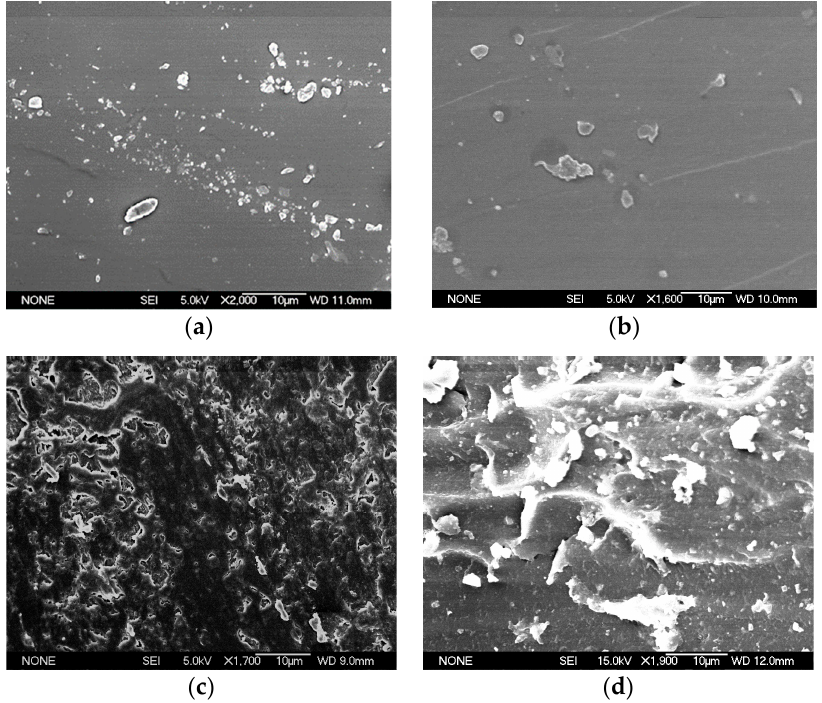
Figure 2. SEM images of various semi-IPNs: ( a ) 2 NRM 20 ; ( b ) 2 NRM 35 ; ( c ) 2 NRM 55 ; ( d ) 4 NRM 50 . Photos taken in magnification from ×1600 to ×2000.